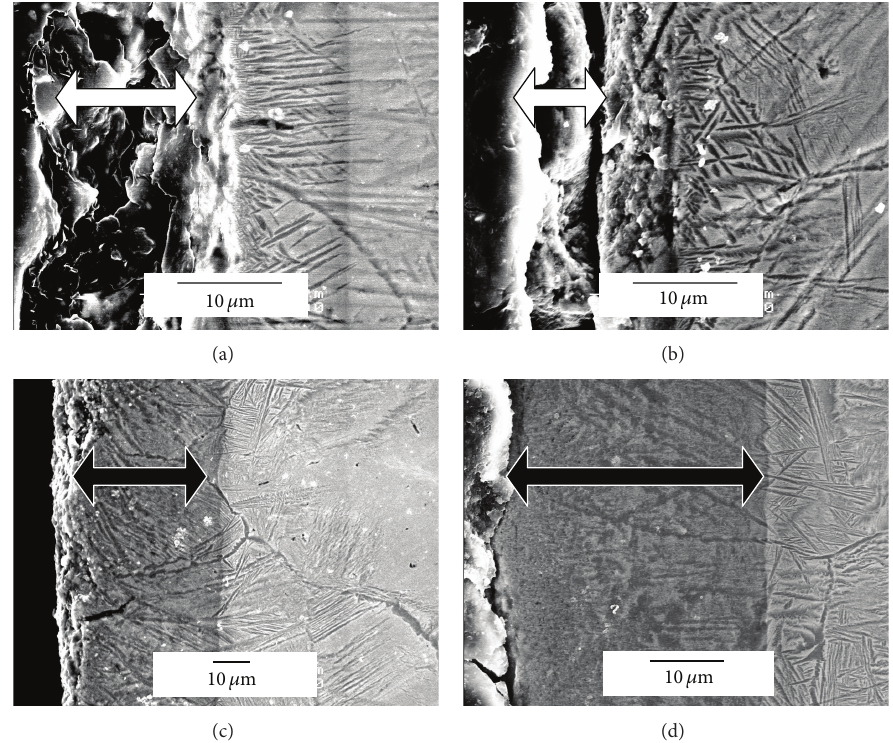
Figure 5: Cross-sectional SEM images of TNTZ. (a) Heated at 900 ∘ C for 0.5 hr, (b) heated at 900 ∘ C for 1hr, (c) heated at 1000 ∘ C for 0.5 hr, and (d) heated at 1000 ∘ C for 1hr. Black arrow: oxidized layer. White arrow: gap formed after the elimination of oxidized layer through sample